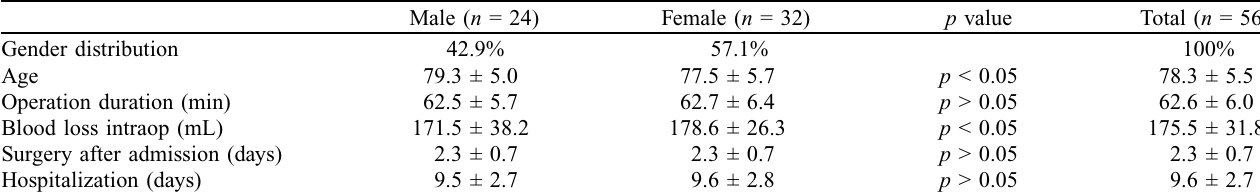
Table 1. Participants and operations